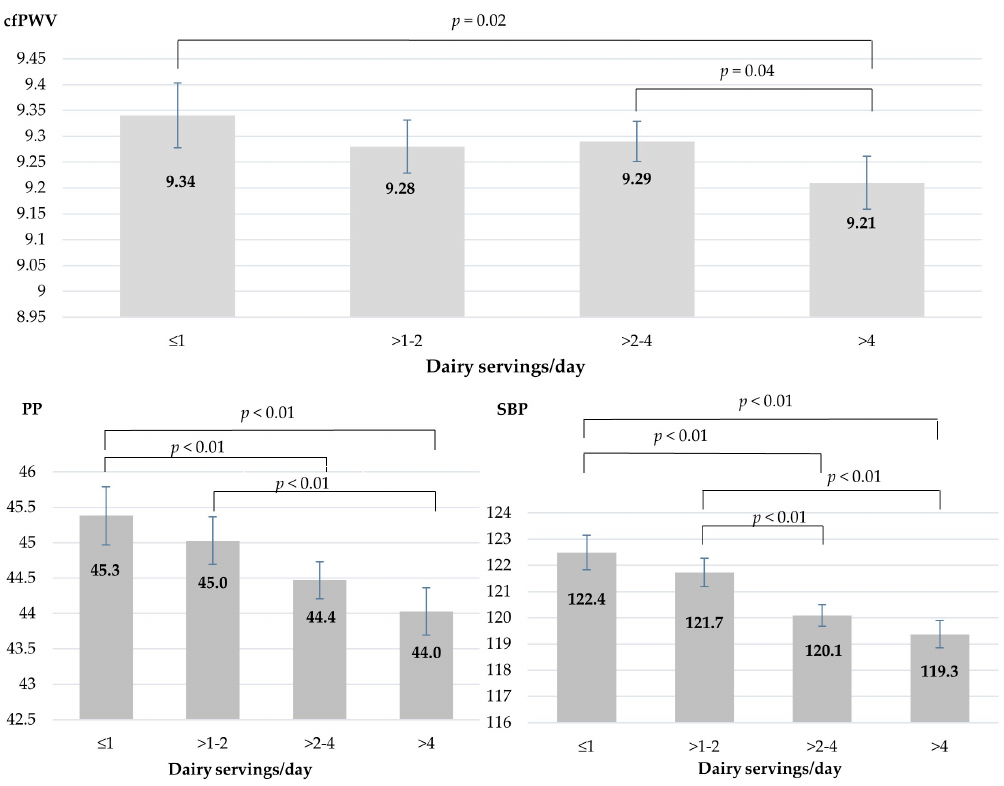
Figure 1. Mean values of carotid-femoral pulse wave velocity (cfPWV), pulse pressure (PP) and systolic blood pressure (SBP) in dairy intake groups after adjustment for variables in Model 4.